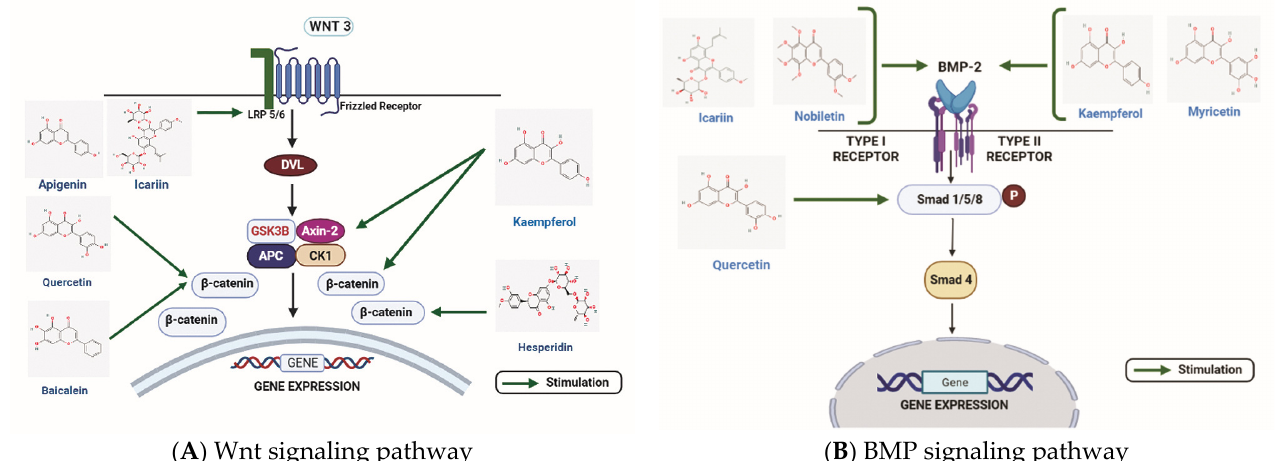
Figure 2. The role of flavonoids in two major signaling pathways inducing bone formation. ( A ) The figure illustrates the stimulatory effects of quercetin, hesperidin, corylin, icariin, apigenin, baicalein on the Wnt/ β -catenin signaling pathway. ( B ) Some of the flavonoids such as icariin, nobiletin, myricetin, and kaempferol stimulate osteogenic differentiation by stimulating the BMP2, whereas quercetin targets the Smad 1/5/8 molecule involved in the BMP signaling pathway for stimulating osteogenesis. WNT: Wingless-related integration site; DVL: Disheveled; LRP 5/6: Lipoprotein receptor-related protein 5/6; GSK3 β : glycogen synthase kinase 3 beta ; Axin-2: Axis Inhibition protein-2; APC: Adenomatous polyposis coli; CK1: casein kinase 1; BMP: Bone morphogenetic protein; Smad: Sup- pressor of mothers against decapentaplegic. (Chemical structures source: PubChem (NCBI, NIH, USA; https://pubchem.ncbi.nlm.nih.gov/) accessed on 7 February 2023, Figures created with Bio- Render.com)).